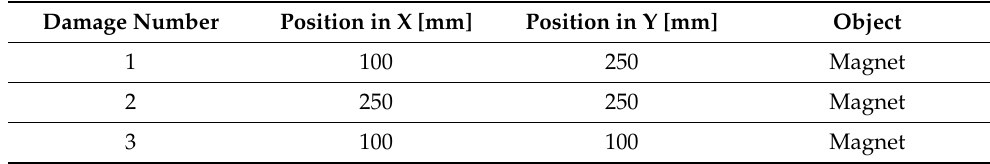
Figure 23. Graphic representation of the second specimen plate. Damages were simulated as masses adhered to the structure whose location is indi- cated in Table 3 based on the coordinate axis shown in Figure 24, which also illustrates the location of damage on the board. With this plate, 25 experiments were carried out in each action phase for each structural state. The piezoelectrics were excited with a tone burst signal with the same characteristics, as in the first experiment presented. Table 3. Damage description in the second specimen aluminium